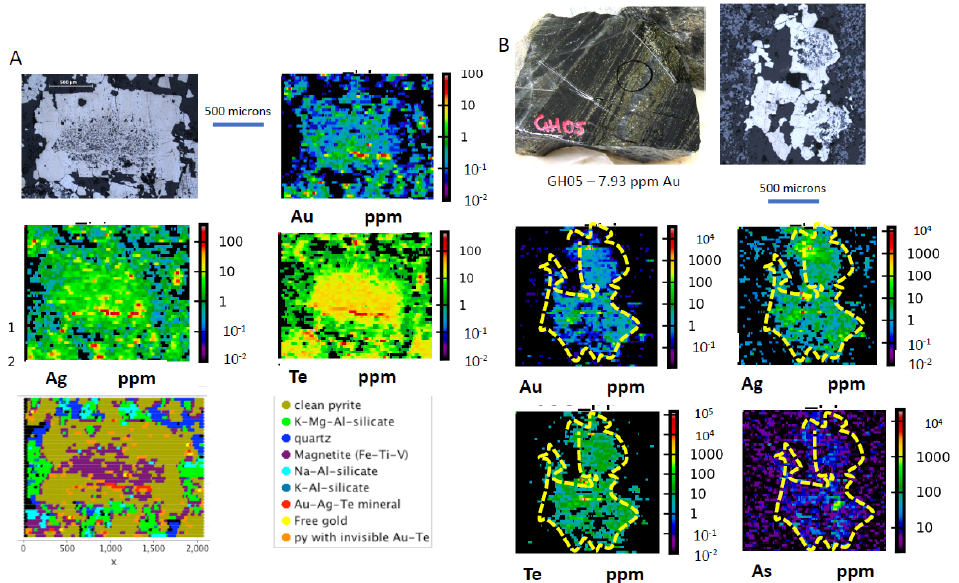
Figure 4. LA-ICPMS maps of pyrite in ppm from Geita Hill. ( A ) Large (2 mm across) euhedral pyrite with fine magnetite inclusions in the core. Laser maps show Au, Ag and Te concentrated in the pyrite core with magnetite inclusions. Red spots on the images represent extra high concentrations of coincident Au, Ag and Te caused by micro-inclusions of Au-Ag tellurides. The bottom left image is a reconstructed mineralogy map based on the laser geochemistry, with the legend to the right. ( B ) Irregular anhedral pyrite aggregate in a silica-rich band in BIF. Micro-inclusion of magnetite in the pyrite represent relicts of sulfidised magnetite. Invisible Au, Ag and Te are throughout the pyrite aggregate, but very little As.